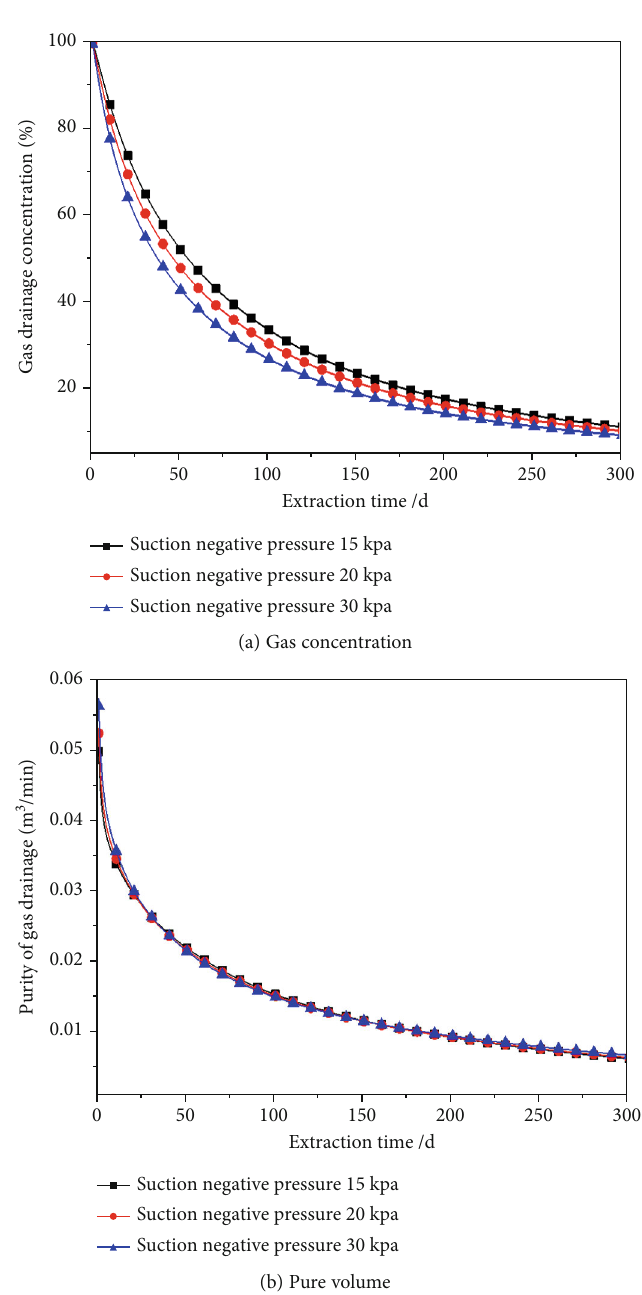
Figure 8: Variation of gas concentration and pure volume with time under di ff erent